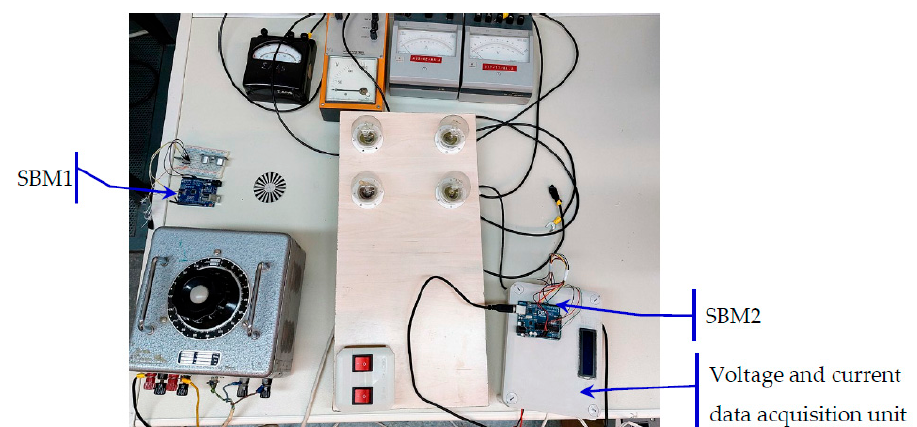
Figure 6. Experimental system (detail): The speed optical encoder rotates with the dc generator’s shaft.